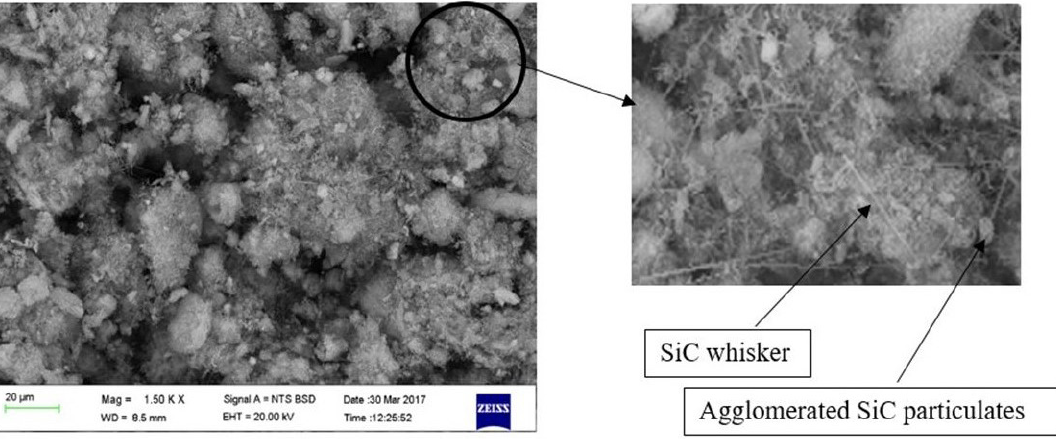
Figure 3: SEM image of SiC powder obtained from rice husk pyrolysed at 1500°C for 120